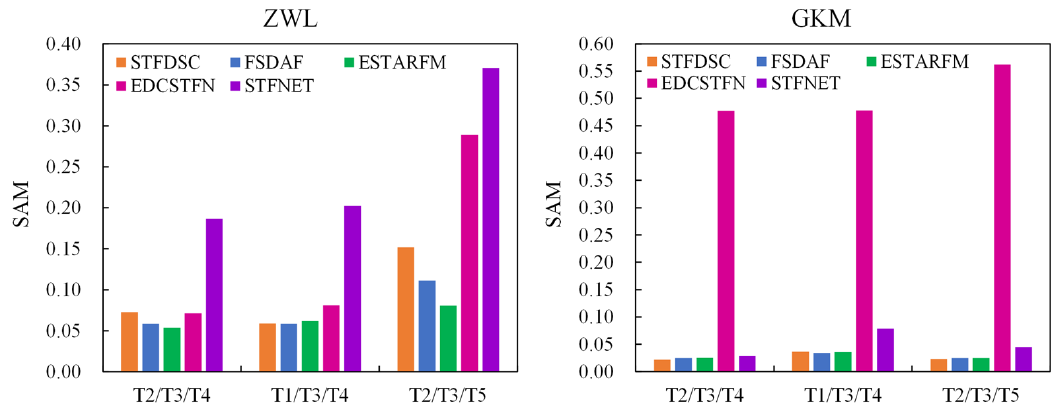
Figure 5. Performance of five STF methods in terms of the SAM index in the ZWL and GKM. 332